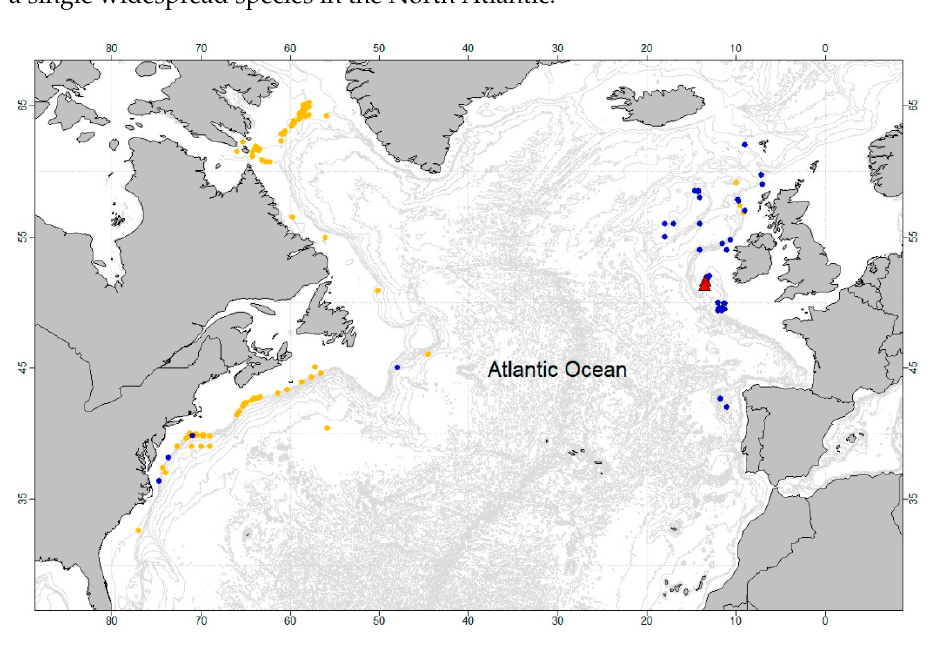
Figure 3. Distribution map showing the records of P. hystrix (blue dots) and P. garmani (yellow dots) reported by GBIF and OBIS, and the literature reviewed. The red triangle marks represent the new locations of P. hystrix reported in this research.